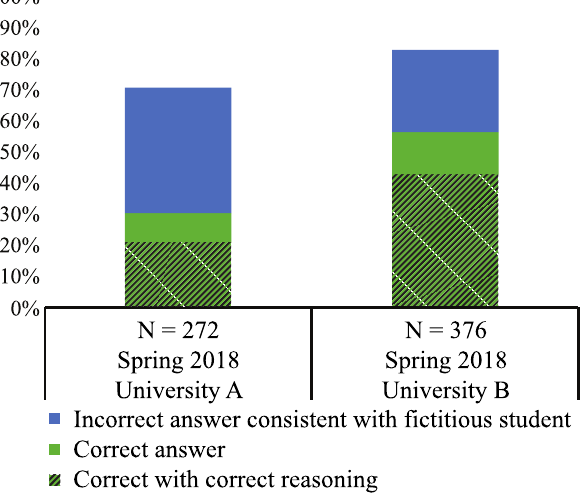
FIG. 6. Student responses on the Newton ’ s laws base task. Shaded areas represent correct answers supported with correct reasoning. All other regions represent answers only, irrespective of the reasoning given. Totals do not sum to 100% because answer choices not aligned with one of the fictitious students are not included.